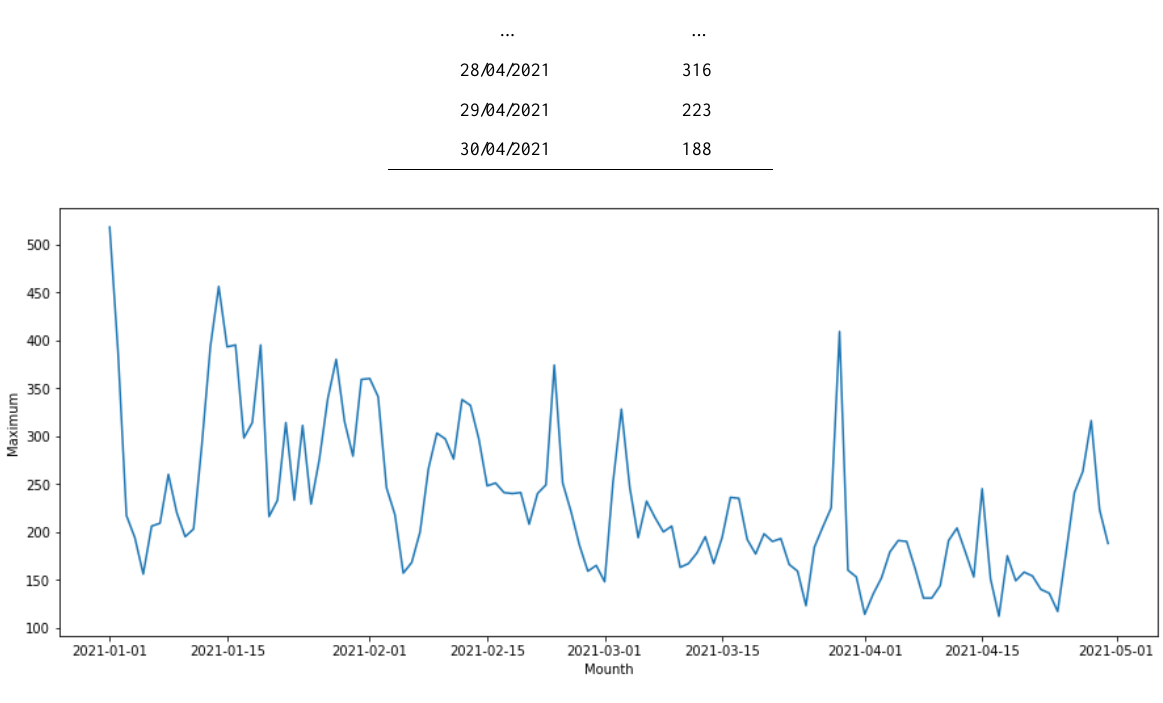
Figure 4. Maximum value graph